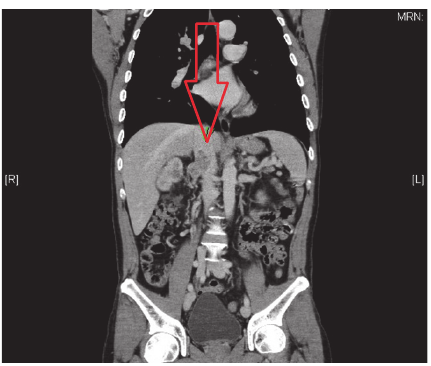
Figure 3: Tumour thrombus in the renal vein extending to the inferior vena cava up to the level as it enters the liver.